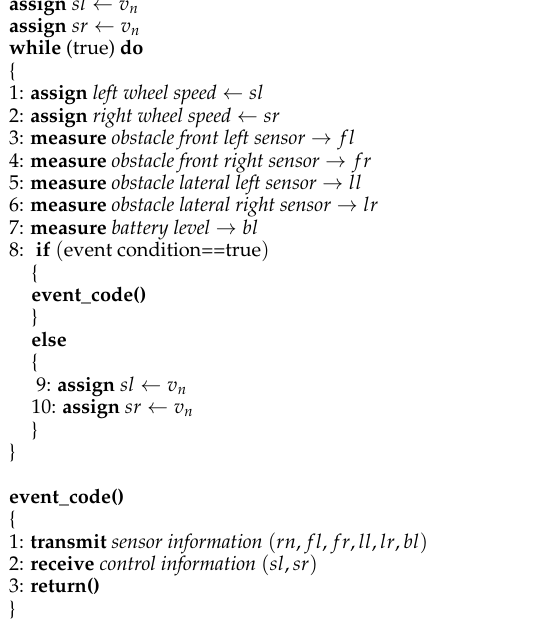
Algorithm A2 Pseudocode in the event-based